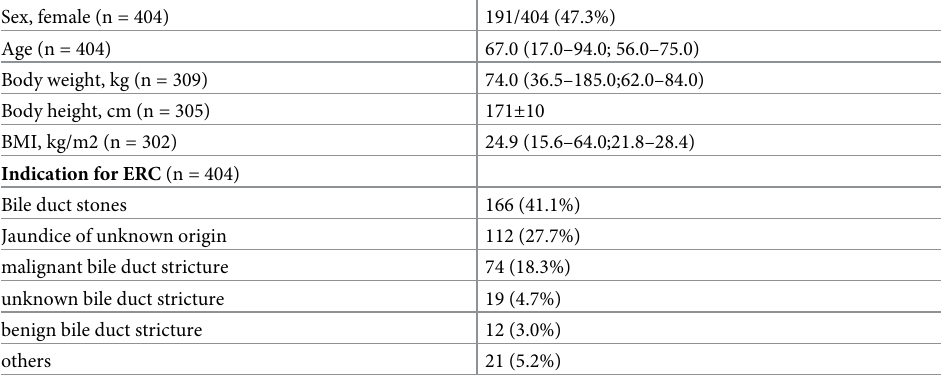
Table 1. Patients´